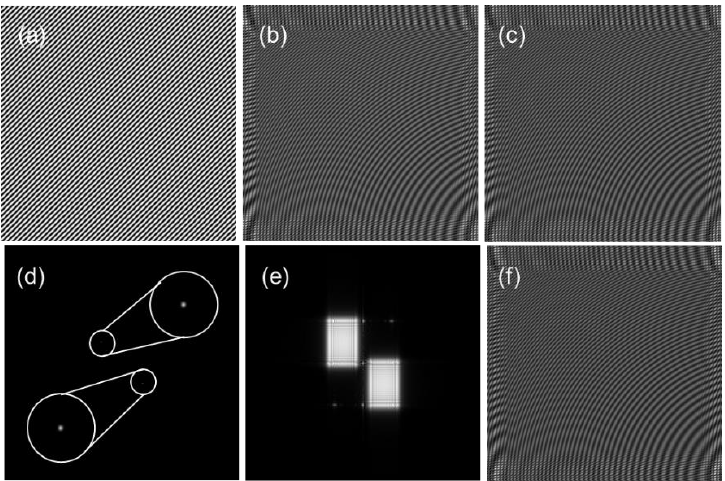
Figure 2. Simulation results: ( a ) I 0 ; ( b ) I 1 ; ( c ) I 2 ; ( d ) spatial spectrum of I 0 ; ( e ) spatial spectrum of I 1 ; ( f ) I 3.